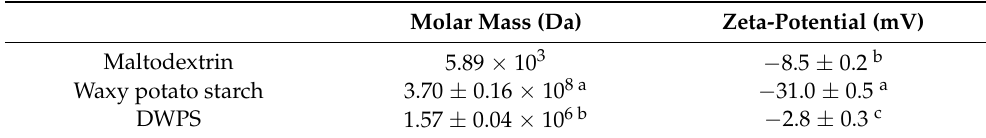
Values are expressed as means ± standard error. Values in the same column denoted with the same superscripts are not significantly different ( p ≤ 0.05). Note that the molar mass and zeta-potential of waxy potato starch and DWPS are obtained from previously reported data [15], and the molar mass of maltodextrin is referenced from Castro et al. [19] whereas the zeta-potential of maltodextrin was determined as described in Section 2.5. The zeta-potential values of the maltodextrin, waxy potato starch, and DWPS were determined at their native